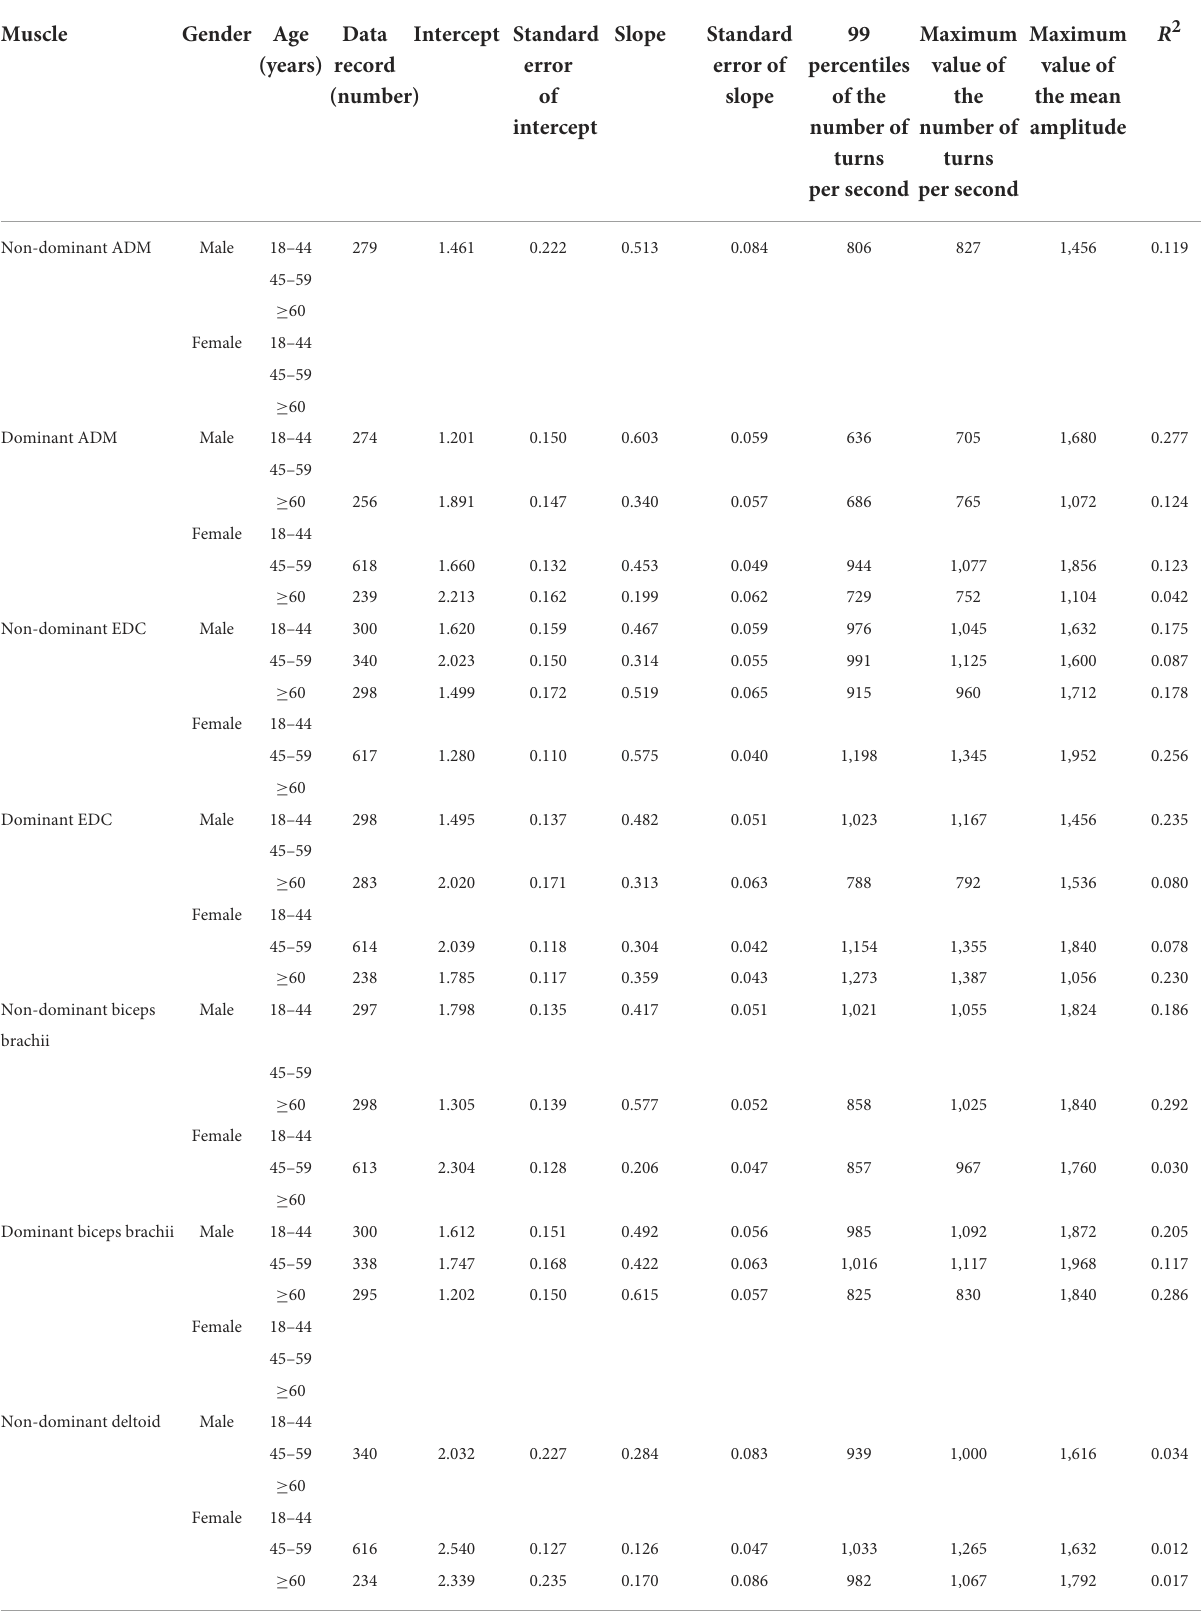
TABLE 7 The reference values of the linear regression